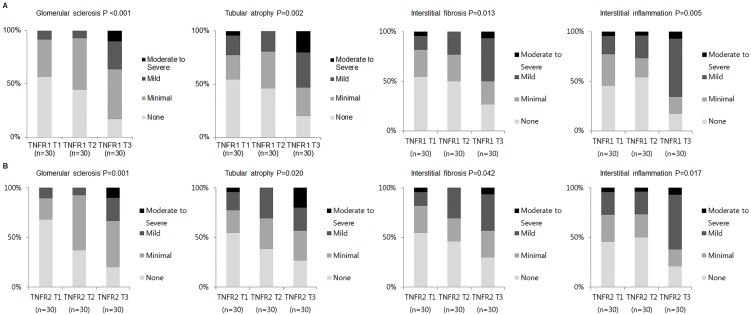
Proportion of the patients based on severity of pathological findings according to circulating TNFRs levels.(A) Correlation between the pathological findings and the circulating TNFR1 tertiles. (B) Correlation between the pathological findings and circulating TNFR2 tertiles.